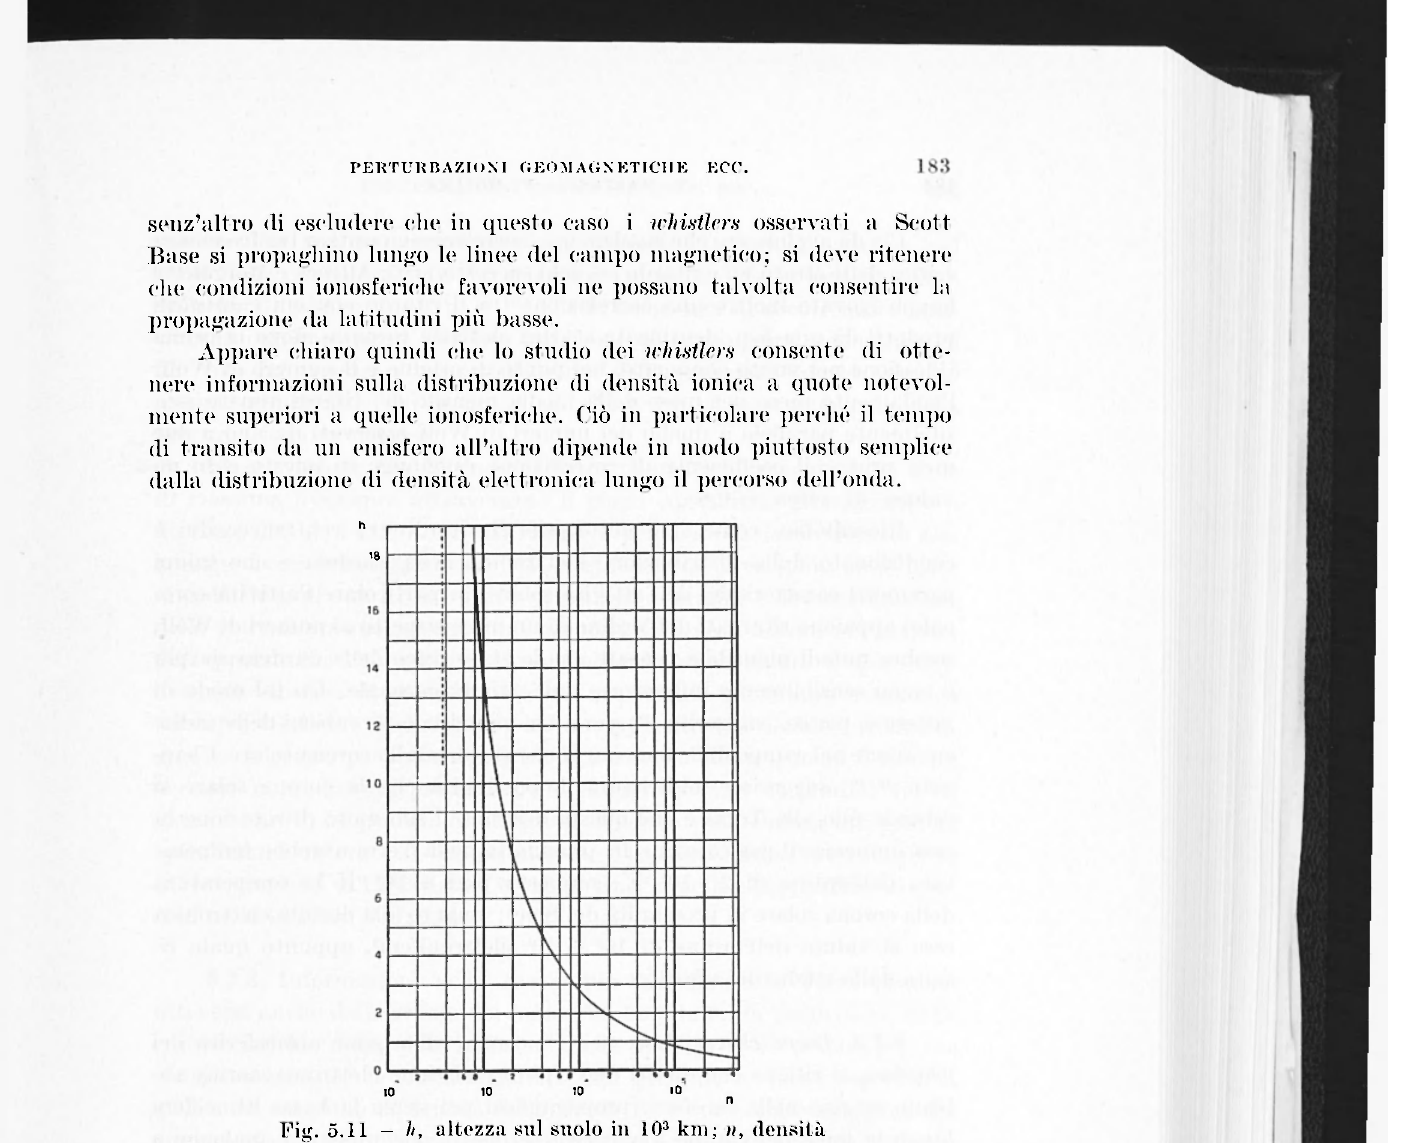
Fig. 5.11 - li, altezza sul suolo in IO 3 km; n, densità elettronica in cnr 1 (secondo